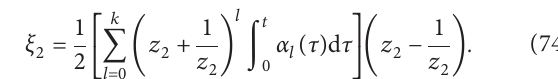
( 0 ) � 1, c ( 0 ) � 2, c ( 0 ) � − 3, z 1 2 3